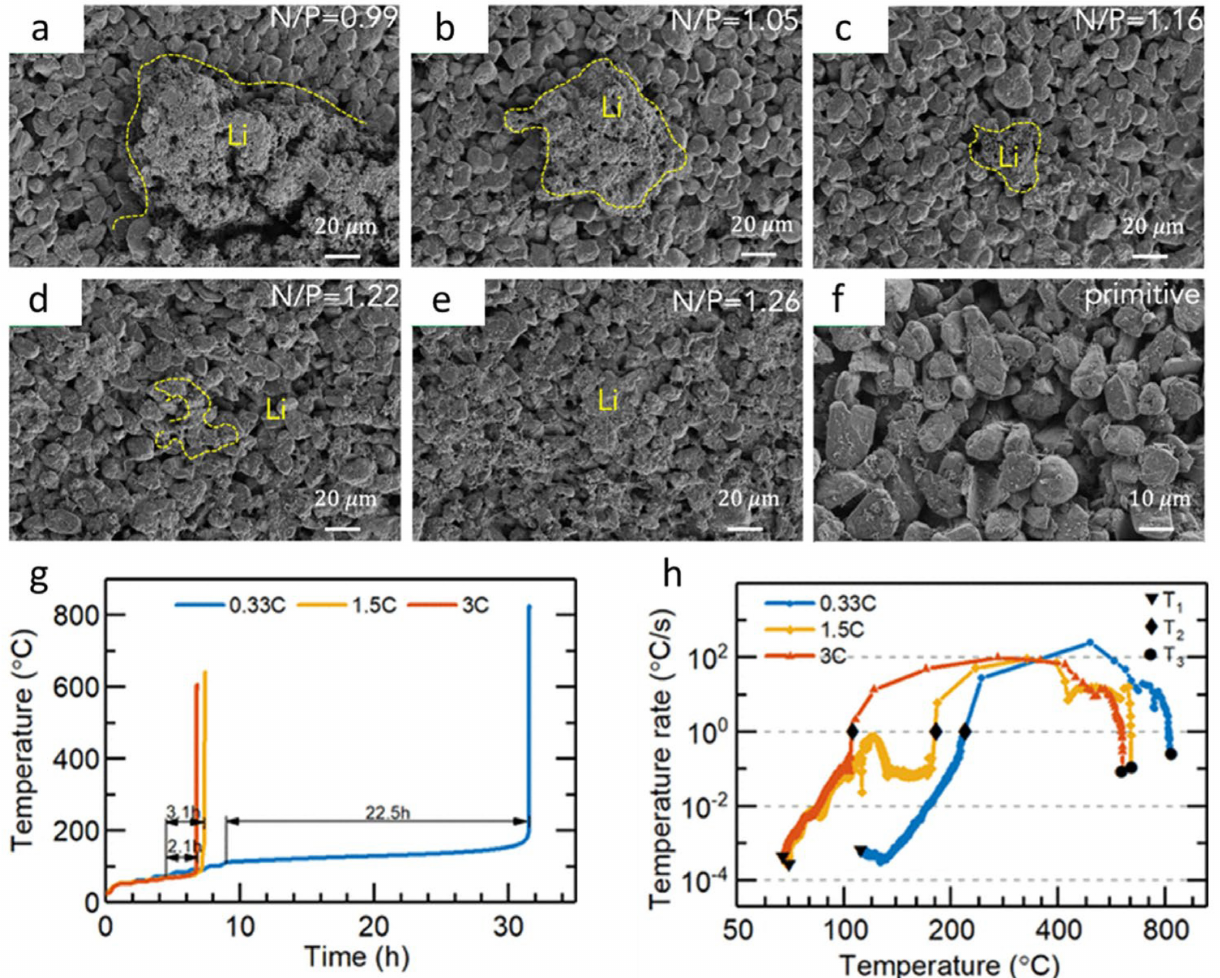
Figure 4. ( a − f ) Images showing the graphite SEM of different N/P battery; Reprinted with permission from Ref. [71]. 2018, Elsevier. ( g , h ) accelerated rate calorimetry (ARC) tests the thermal runaway behavior of batteries at different charging rates (0.33 C, 1.5 C, and 3 C). Reprinted with permission from Ref. [75]. 2019, ACS